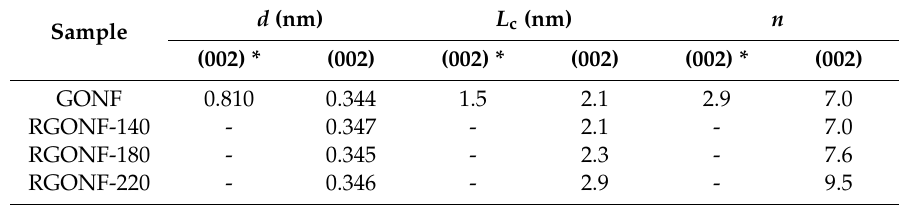
Figure 2. X-ray diffraction (XRD) patterns of GONF and RGONFs obtained at 140, 180, and 220 °C. Table 1. Structural parameters of GONF and RGONFs obtained at 140, 180, and 220 °C determined by XRD.